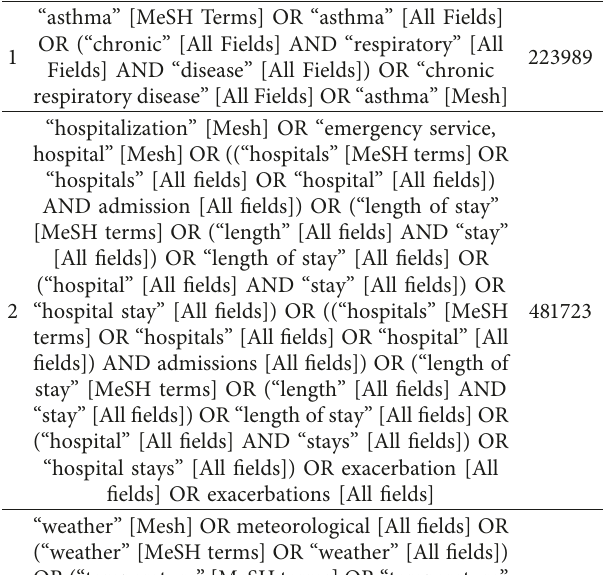
Table 1: Literature search strategy for PubMed and number of identified